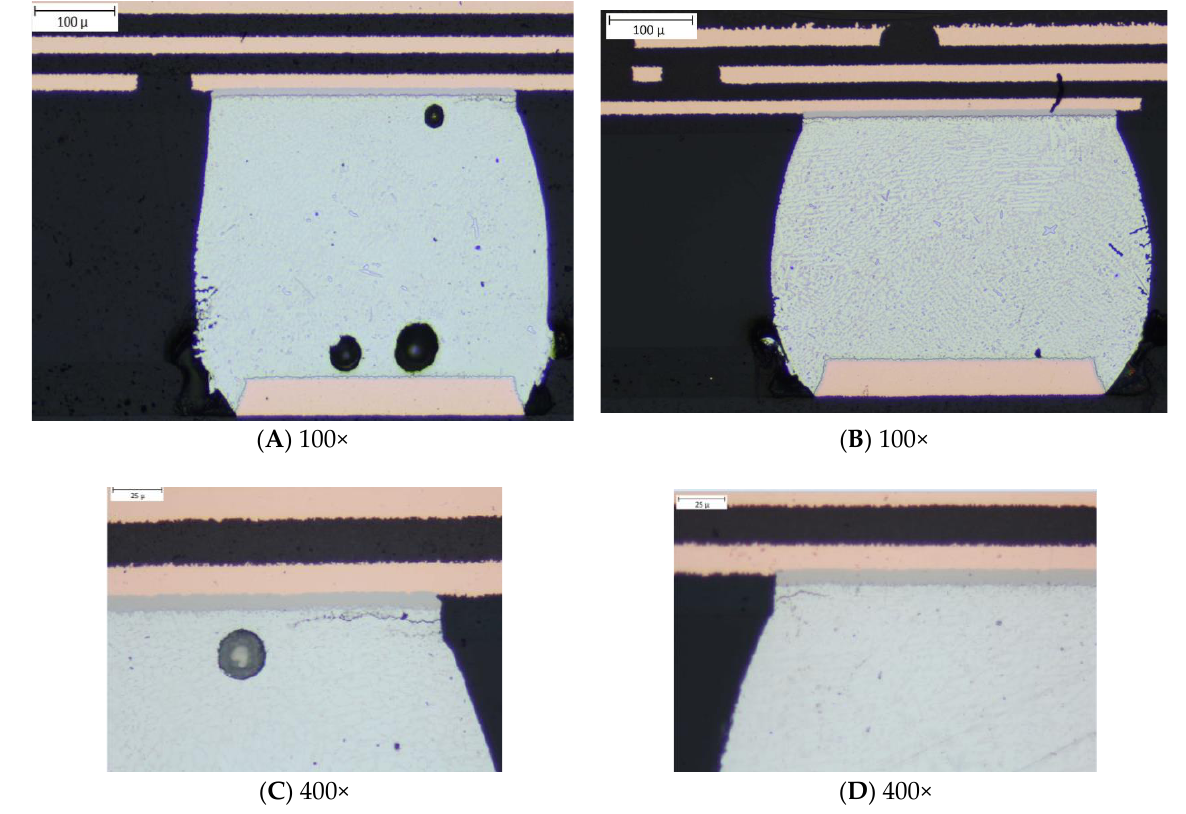
Figure 14. Optical microscopic images of the cracked solder ball: ( A , C ) 1.6-mm board, ( B , D ) 1-mm board.